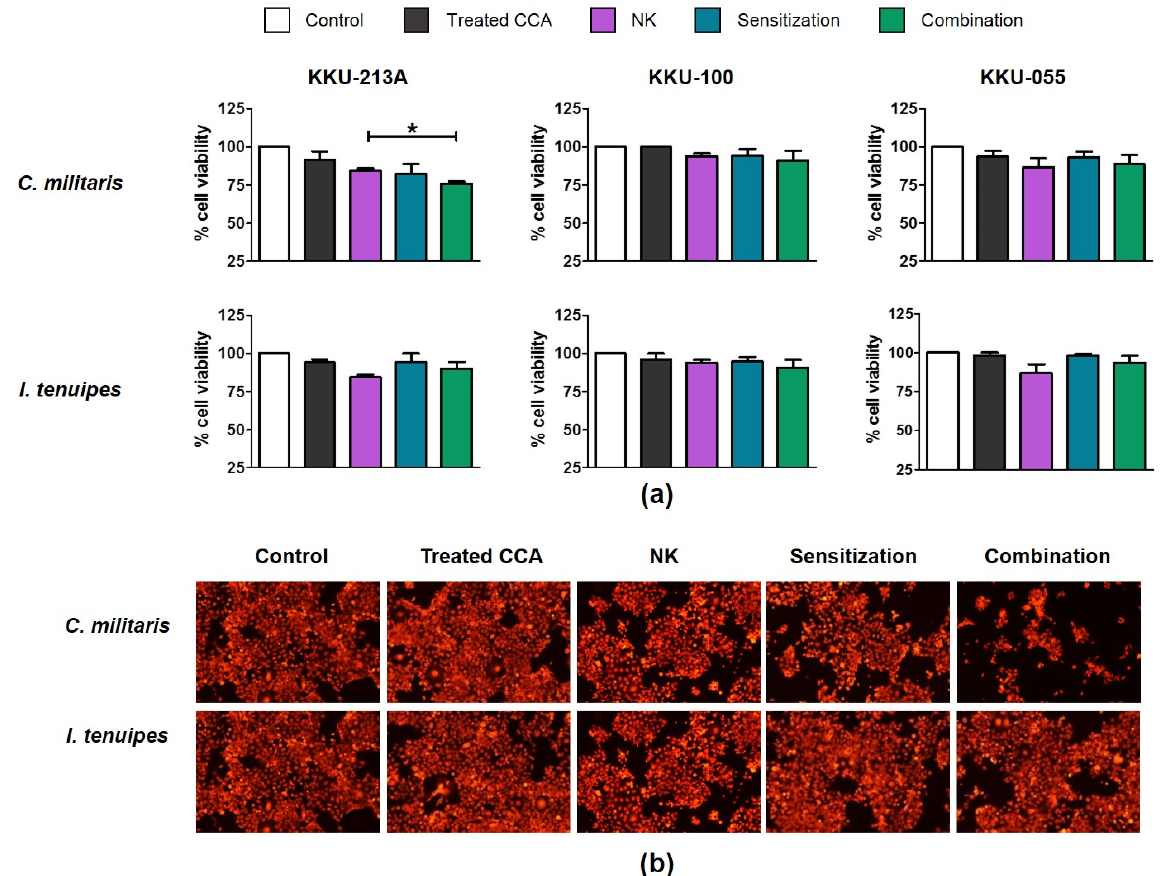
Figure 5. The NK cell activity with the extracts enhancement to eliminate CCA cell lines. The effect of C. militaris and I. tenuipes extracts to enhance NK killing ability was determined in KKU-213A, KKU-100, and KKU-055 by killing assay ( a ) . The killing assay was conducted with 24-hour incubation time using the E/T ratio of 1:1. The number of KKU-213A living cells after a combined NK cell co-culture under sensitization and combination conditions was observed under the fluorescence microscope ( b ) . The statistical differences were analyzed comparing combined cordycepin-NK treatment vs. single NK treatment, in which * indicates p < 0.05.